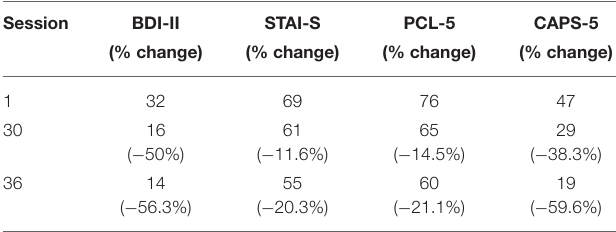
TABLE 1 | Clinical outcomes for combined rTMS